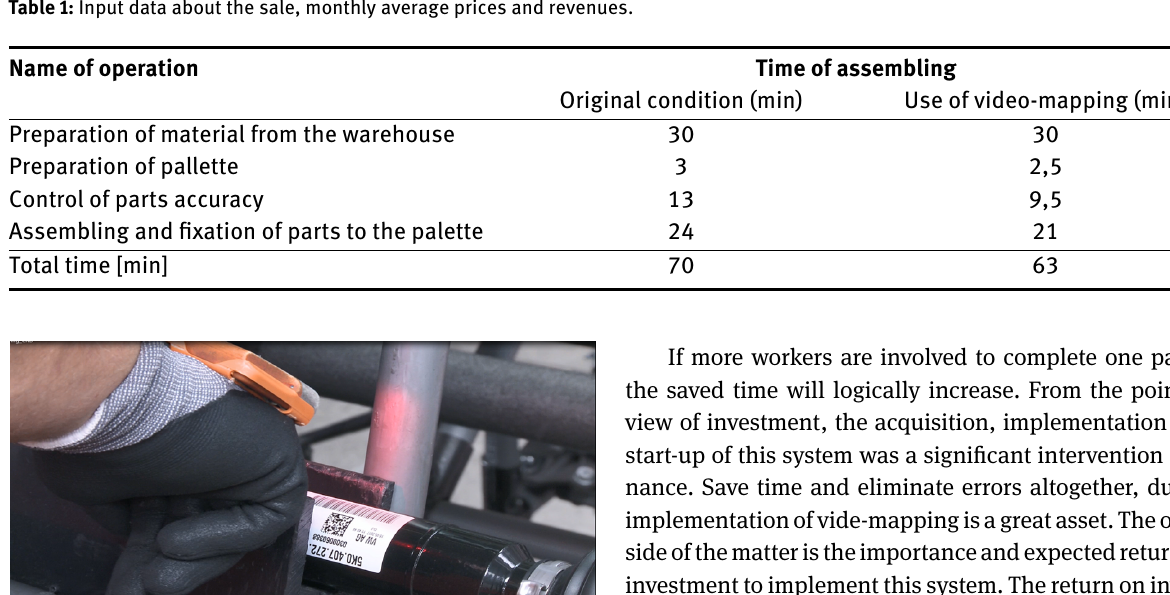
Table 1: Input data about the sale, monthly average prices and revenues.